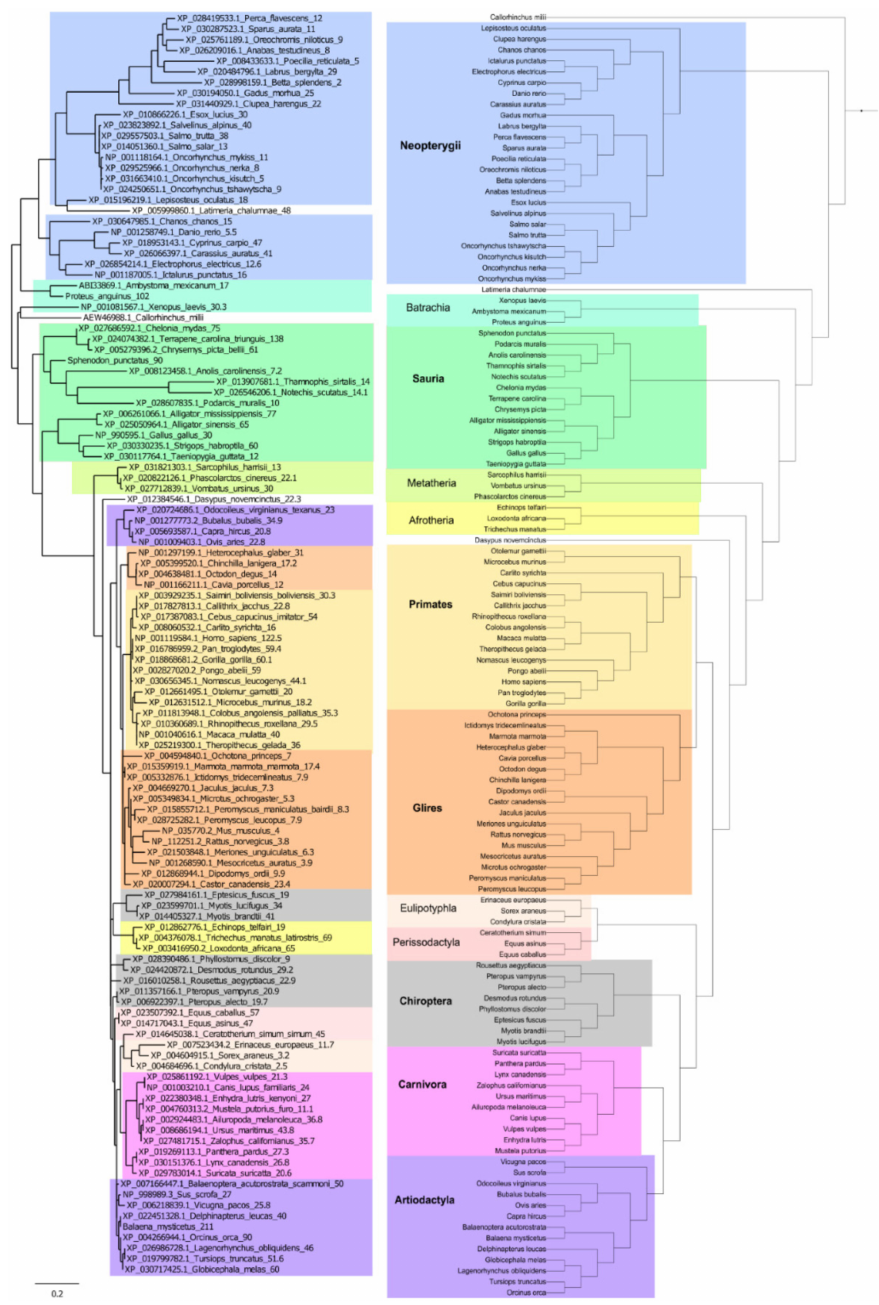
Figure 5. The p53-based and contemporary phylogenetic trees. Comparison of the p53 protein tree ( left ) and the real phylogenetic tree ( right ). The protein tree was built using the Phylogeny.fr platform. Organismal phylogeny was reconstructed using PhyloT and visualized in iTOL (see the Materials and Methods section for details). The same color backgrounds represent the same phylogenetic